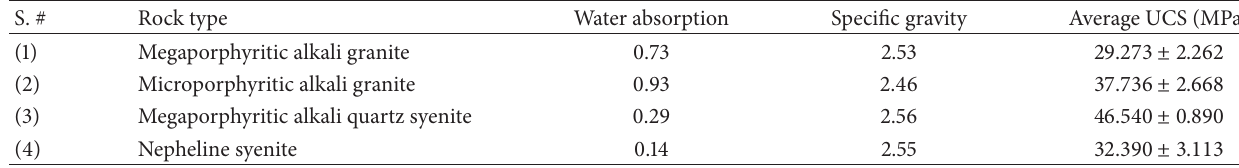
Table 2: Values of water absorption (%) and specific gravity and their relationship with UCS.